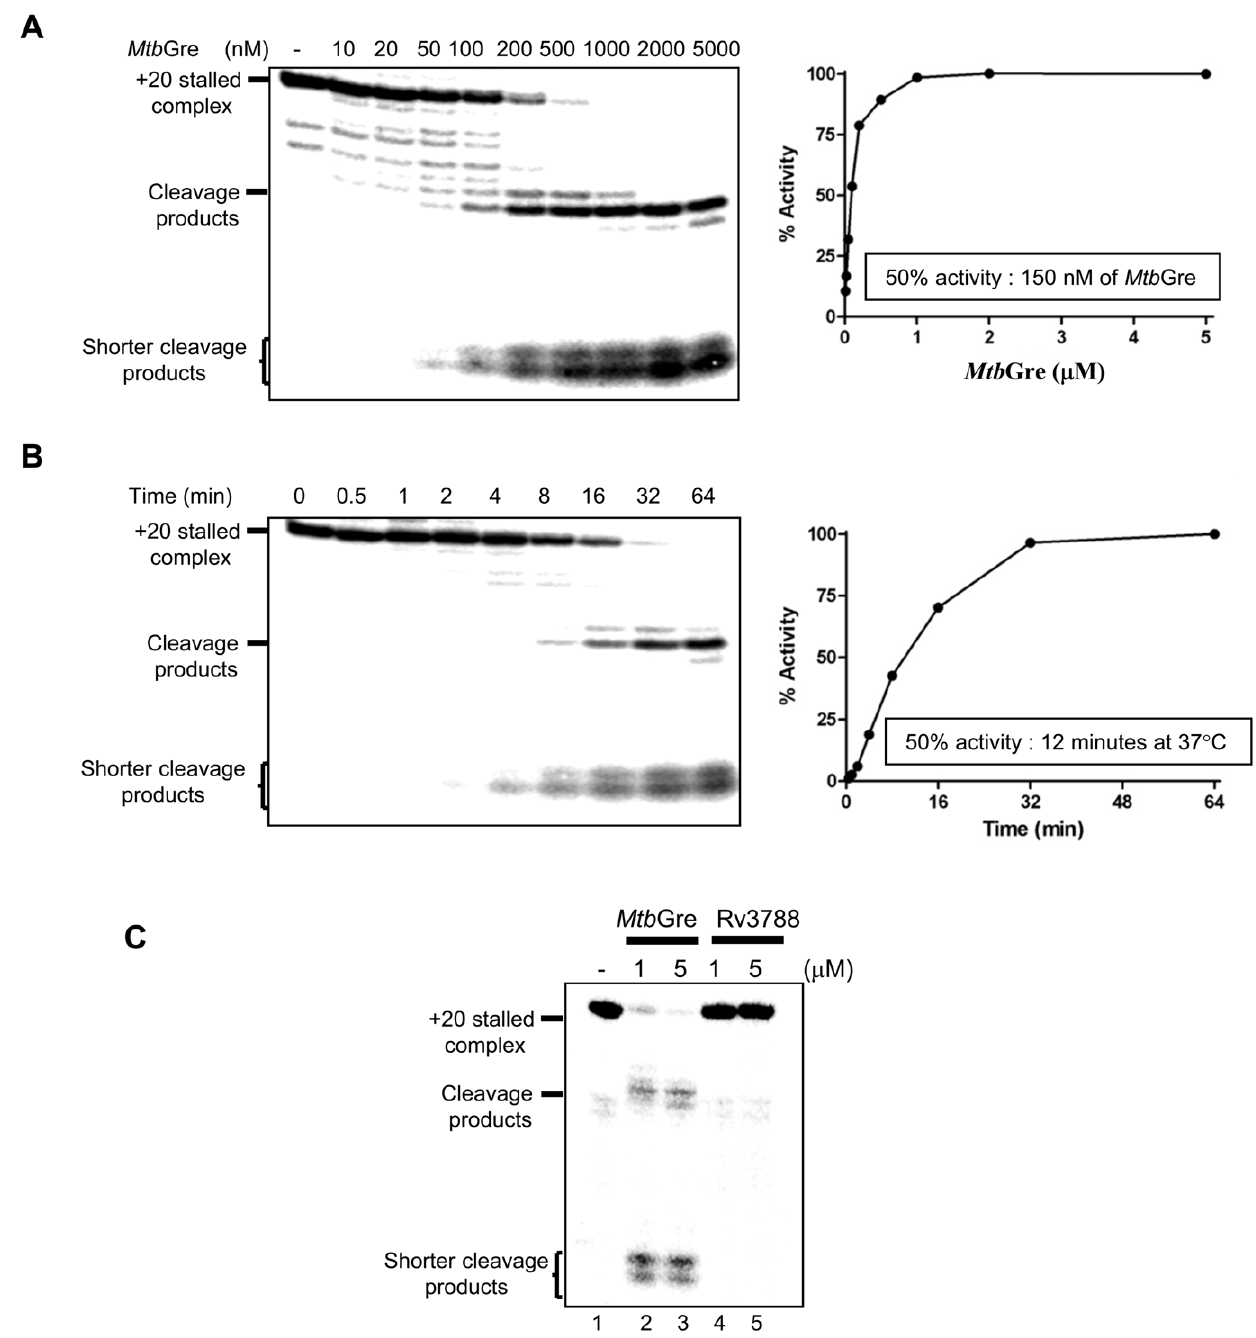
Figure 2. Mtb Gre factor stimulates the cleavage of 20 mer transcript. ( A ) Determination of the unit activity of Mtb Gre. Stalled TEC generated with M. smegmatis RNAP was incubated with different concentrations of Mtb Gre (10 nM to 5 m M) for 30 mins. Reactions were terminated and resolved on a 20% urea PAGE. ( B ) Time-course of Mtb Gre activity. Stalled TECs were incubated at 37 u C with 1 m M Mtb Gre and aliquots were removed at different time points and quenched with urea gel loading dye followed by resolving on a 20% urea PAGE. The time required for 50% cleavage of the TEC was calculated from the plot. ( C ) The Mtb Gre homolog-Rv3788 does not induce transcript cleavage. Mtb Gre could induce the cleavage of + 20 nt stalled elongation complex at T7A1 template (lanes 2 and 3). Rv3788 does not have detectable transcript cleavage stimulatory activity (lanes 4 and 5).